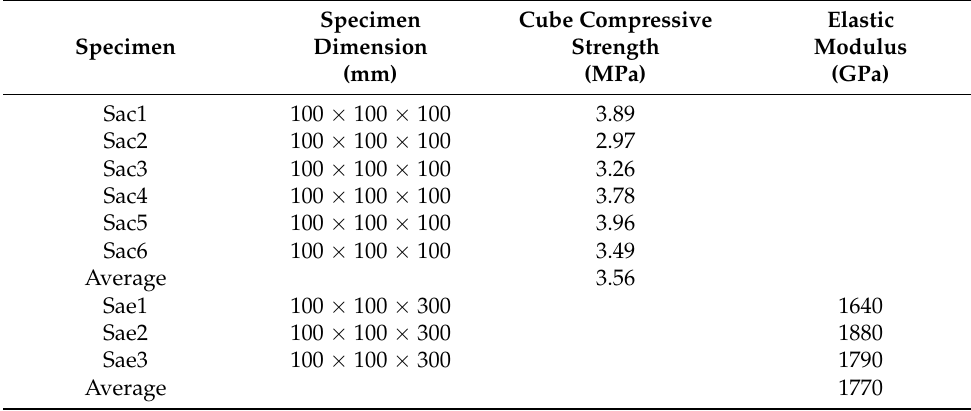
Table 2. Mechanical properties of steel.